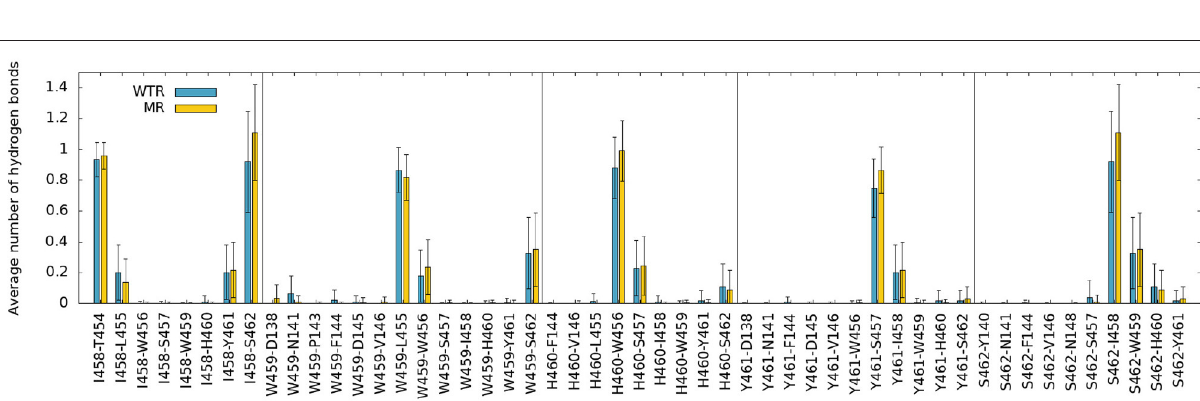
FIGURE 3 | (A) Average dynamic correlation of residue 441 backbone atoms with those of residues 448 and 459, for the WTR (blue) and the MR (yellow) in the two replicas R0 and R1. Subscripts denote the five subunits. (B) Position of residues 441, 448, and 459 in the protein.